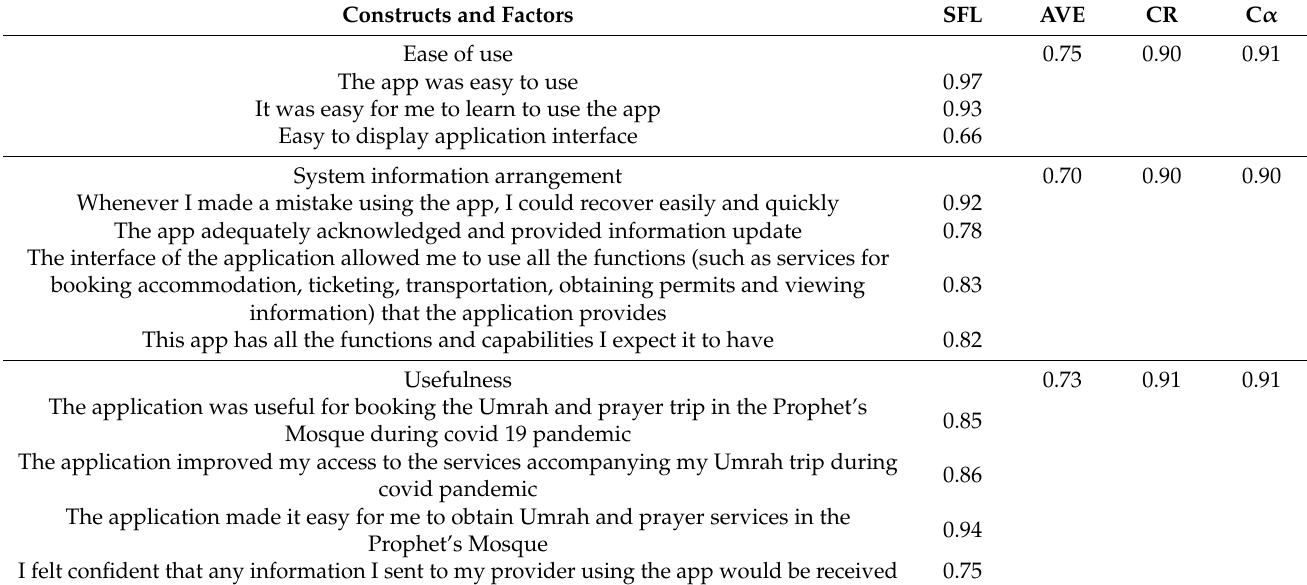
Table 2. Results of the confirmatory factor analysis of different